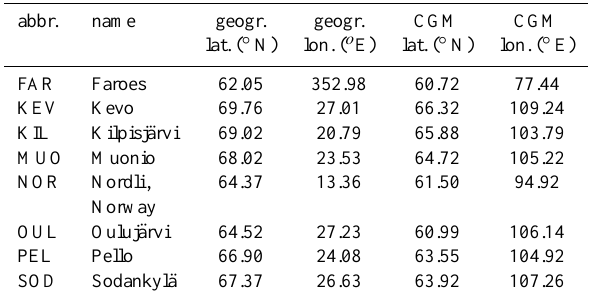
Table 1. Ground stations of this case